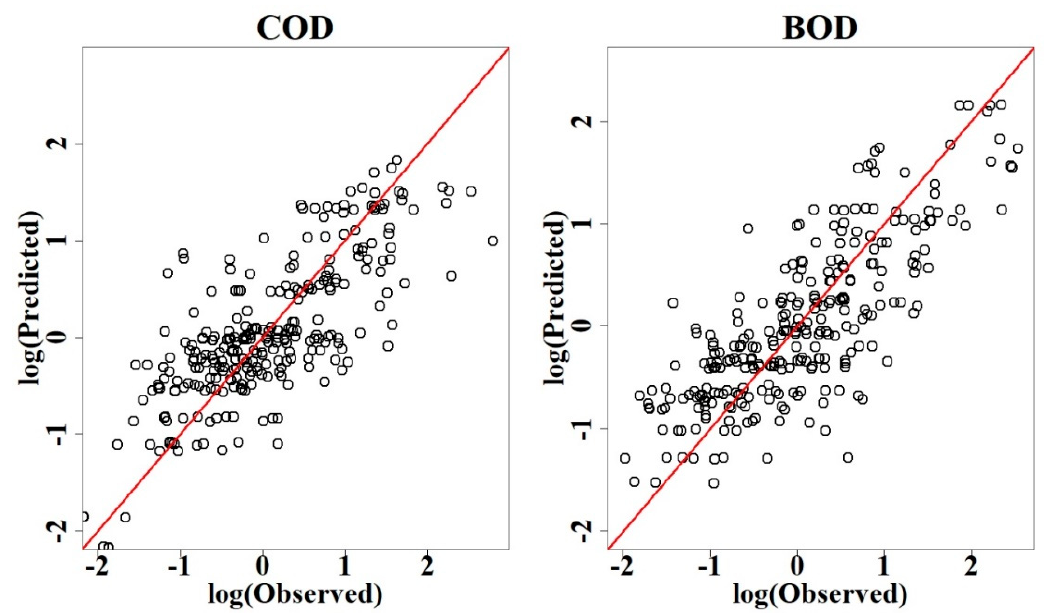
Figure 5. Observed against predicted COD and BOD from BN models at the EUC scale.